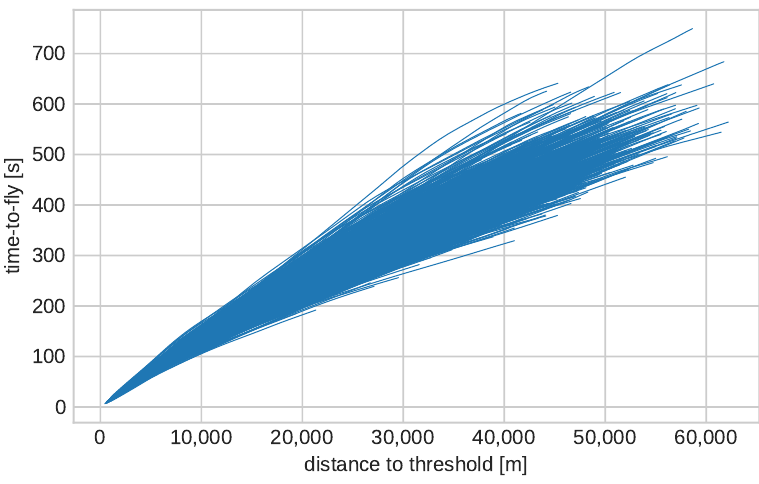
Figure 5. Time-to-fly above the distance to threshold.